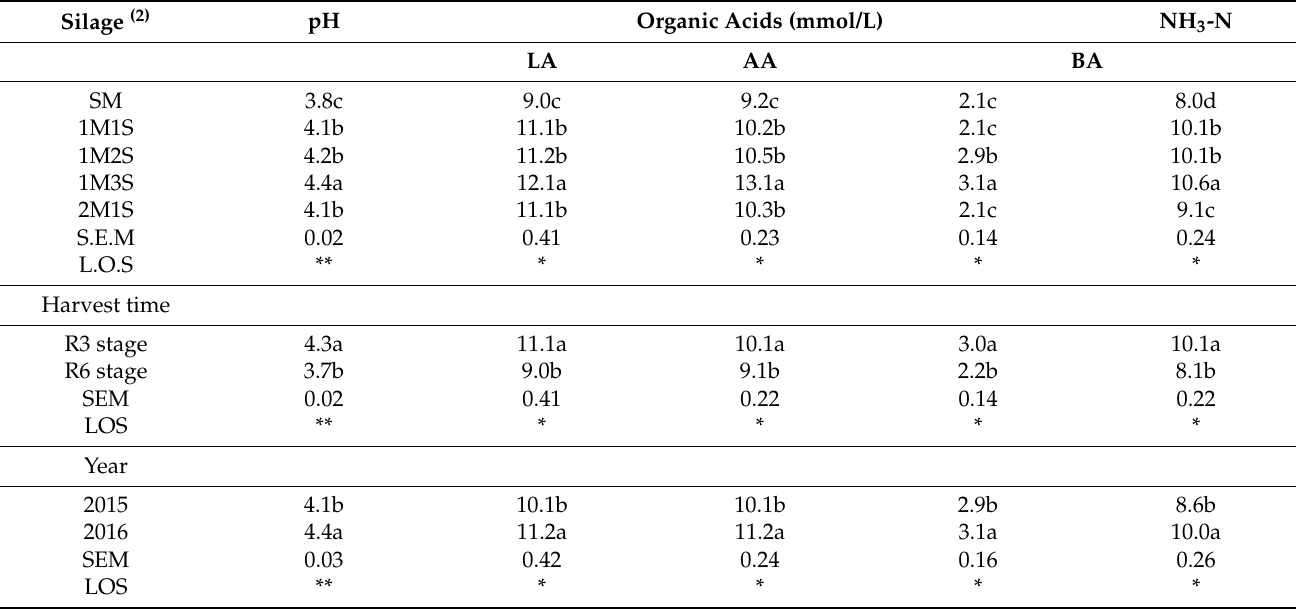
Table 3. Fermentation quality of maize and intercropped maize-soybean silage on dry matter basis (% DM) (1) of two maturity